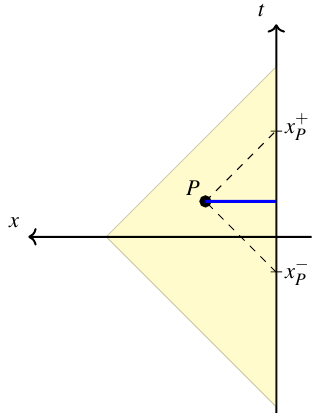
; x (cid:0) ). The P P